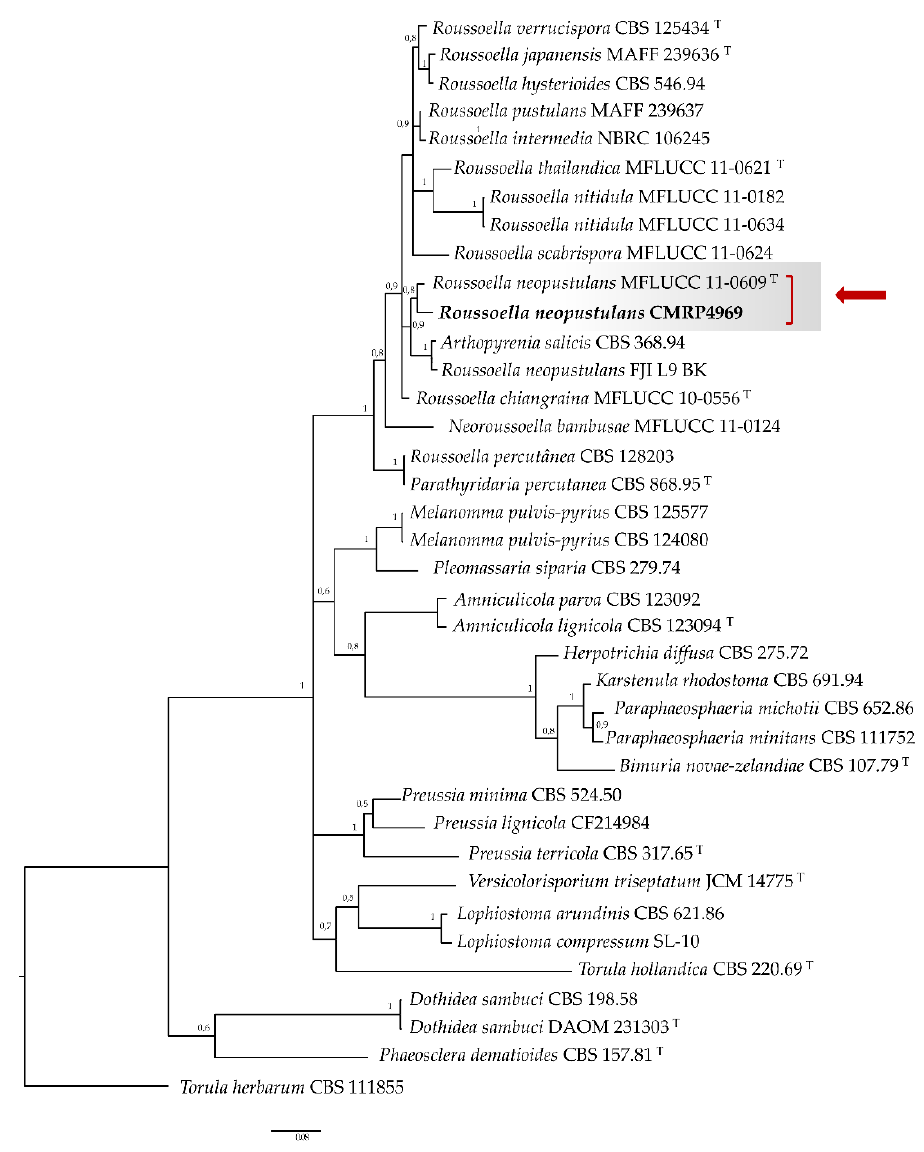
Figure 2. Phylogenetic tree of Roussoella species based on aligned rDNA Internal Transcribed Spacer (ITS) sequences, obtained by Bayesian analysis. Torula herbarum CBS 111855 was taken as an outgroup. T = Type strain. The sequences of this study are indicated in bold. Values of ≥ 95% for Bayesian probability resampled datasets are shown with the branches.